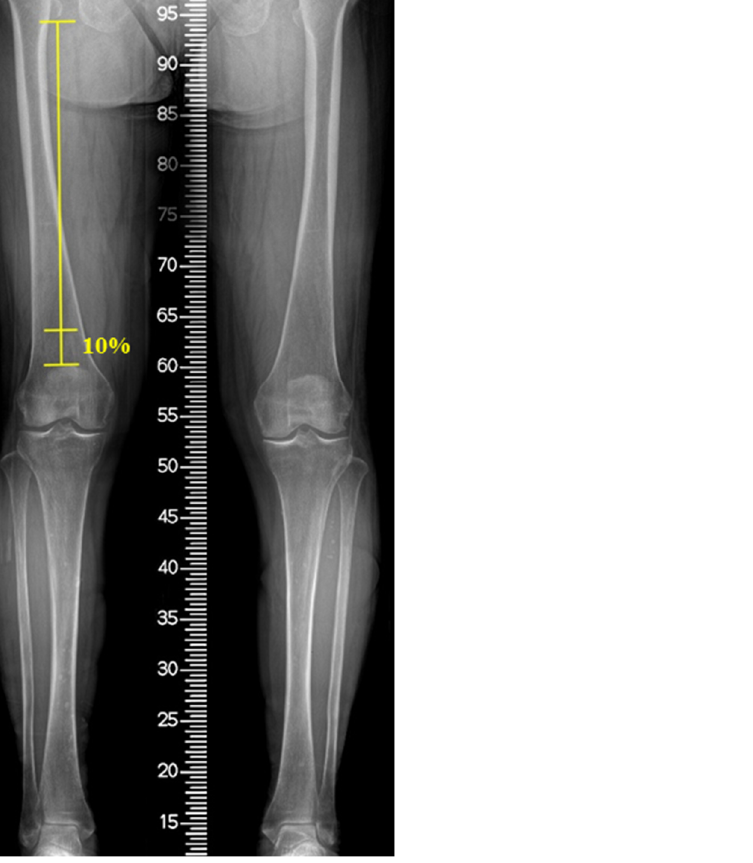
Figure 2. Measurement of the femoral length (FL), defined as the distance from the distal end of lesser trochanter to the superior surface of patella in full-length standing anteroposterior radiograph.